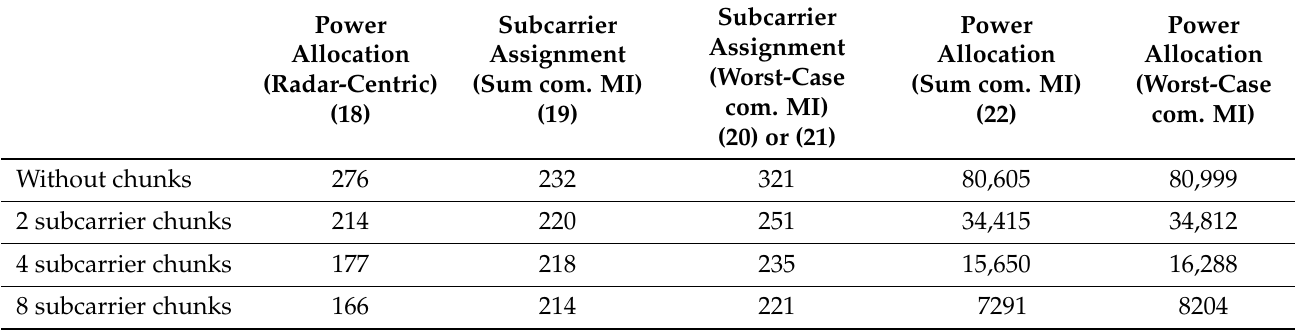
Table 3. Average computation time (ms) for the proposed resource allocation strategies: K = 1024 subcarriers, R = 2 users, and channel conditions from Figure